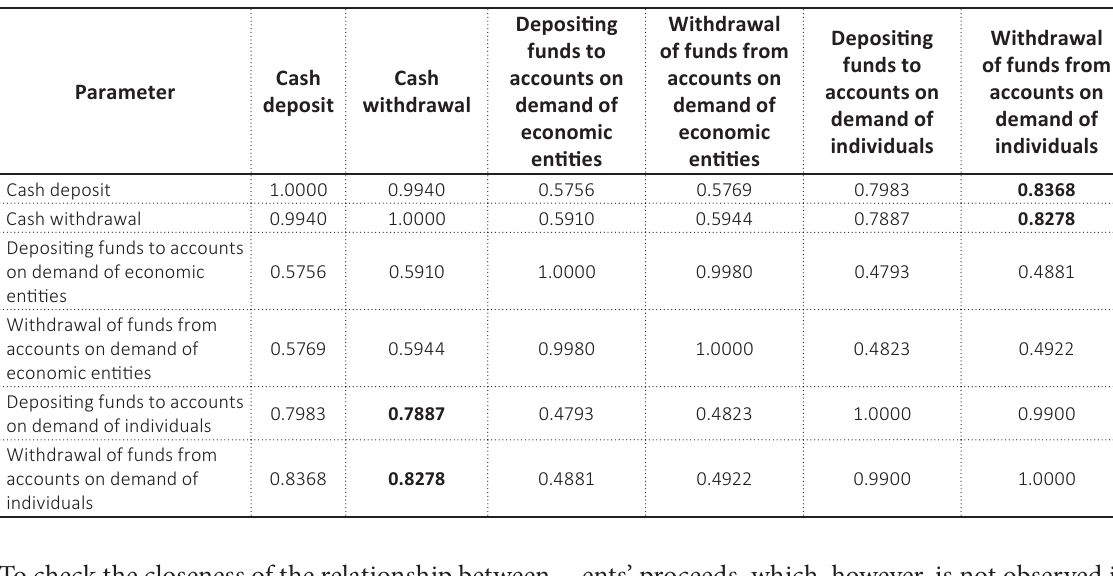
Table 4. Coefficients of pairwise correlation between indicators of cash and non-cash flows of clients of JSC “JSCB